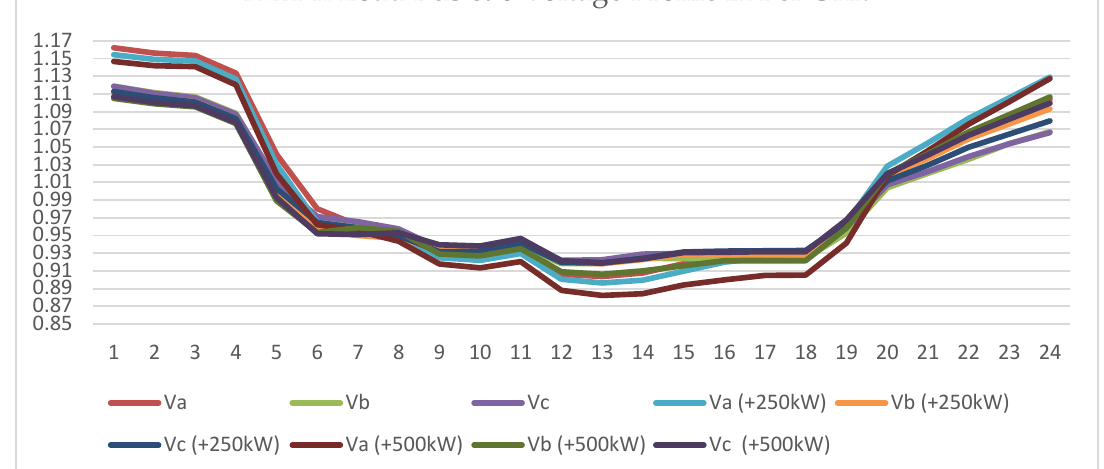
Figure 6. Case 1-1 Bus 890 Voltage (in PU) per Each Hour in the day.